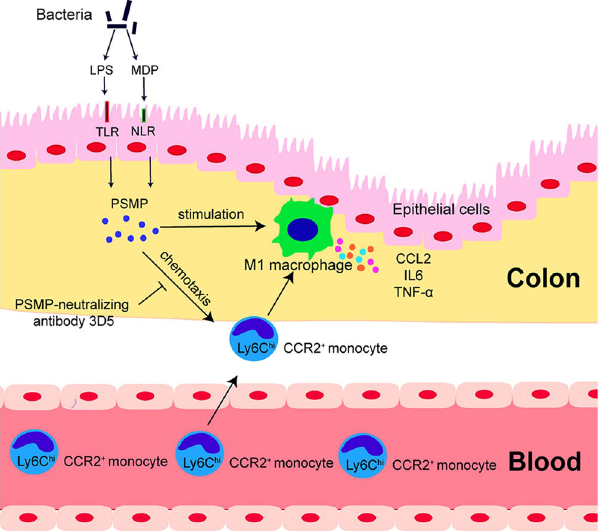
Figure 8. Summary diagram of the mechanisms by which the PSMP-CCR2 system affects colitis. The bacterial products LPS and MDP stimulate colonic epithelial cells to produce PSMP at the early stage of colitis prior to IL-6, TNF- α and CCL2 up-regulated expression. PSMP recruites Ly6C hi CCR2 + monocytes from blood to injuried colon via a CCR2-dependment manner and promotes M1 macrophages to produce CCL2. Secreted CCL2 further recruites Ly6C hi CCR2 + monocytes from blood to inflammation sites and enlarges the reaction to promote colitis in turn. A neutralizing antibody of PSMP can mollify colitis by reducing macrophage